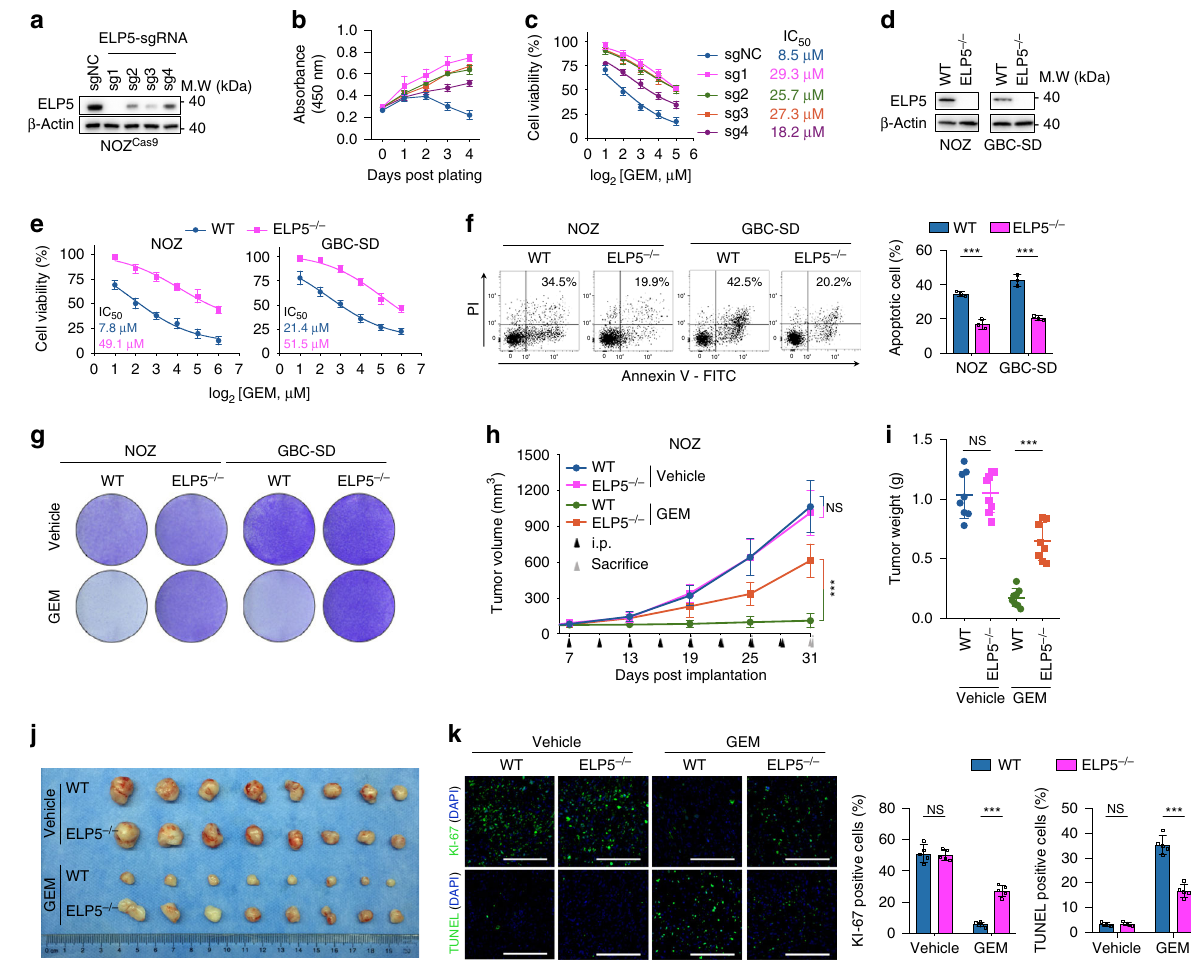
Fig. 2 Loss of ELP5 in GBC cells mediates GEM resistance both in vivo and in vitro. a ELP5 protein was signi fi cantly depleted in NOZ Cas9 cells infected with lentivirus-delivered ELP5 -targeting sgRNAs, which were utilized in CRISPR screens. b , c ELP5 -knockout cells exhibited increased cell viability under GEM treatment in time- ( b ) and dose-dependent manners ( c ). d Single-cell clones of the complete ELP5 knockout ( ELP5 − / − ) in two GBC cell lines, NOZ and GBC-SD, were generated using CRISPR/Cas9. The wild-type (WT) cells were transfected with the same vector carrying non-speci fi c control sgRNA. e , f ELP5 -depleted cells exhibited resistance to GEM, as assessed by cell viability assay under GEM treatment for 72 h at indicated doses ( e ) and apoptotic assay by Annexin-V/PI staining for fl ow cytometry after GEM treatment for 72 h at IC 50 ( f ). g Representative images of cell densities in WT and ELP5 − / − cells treated with GEM at IC 50 or vehicle and stained with crystal violet. h – k ELP5 depletion prevented xenograft growth inhibition and apoptosis induced by GEM intraperitoneal injection (i.p.) in NOZ cell xenografts, but was dispensable for xenograft growth when treated with vehicle (saline), as evaluated by tumor growth volume ( h ), tumor weight ( i ), representative images ( j ) of xenograft tumors after scari fi cation, and KI-67 (upper) and TUNEL (down) staining in paraf fi n- fi xed xenograft tissues after scari fi cation ( k ). Scale bars = 200 μ m. 1 × 10 6 WT or ELP5 − / − NOZ cells were injected subcutaneously into the right axilla of athymic nude mice ( n = 8 animals per group). Data represent the mean ± S.D. in b , c , e , f ( n = 3 independent experiments), h , i ( n = 8 per group) and k ( n = 5 per group), error bars represent S.D. Unpaired Student ’ s t -tests were used in b , c , e , f , i , k , and one-way ANOVA was used in h (NS, non-signi fi cant, *** P <